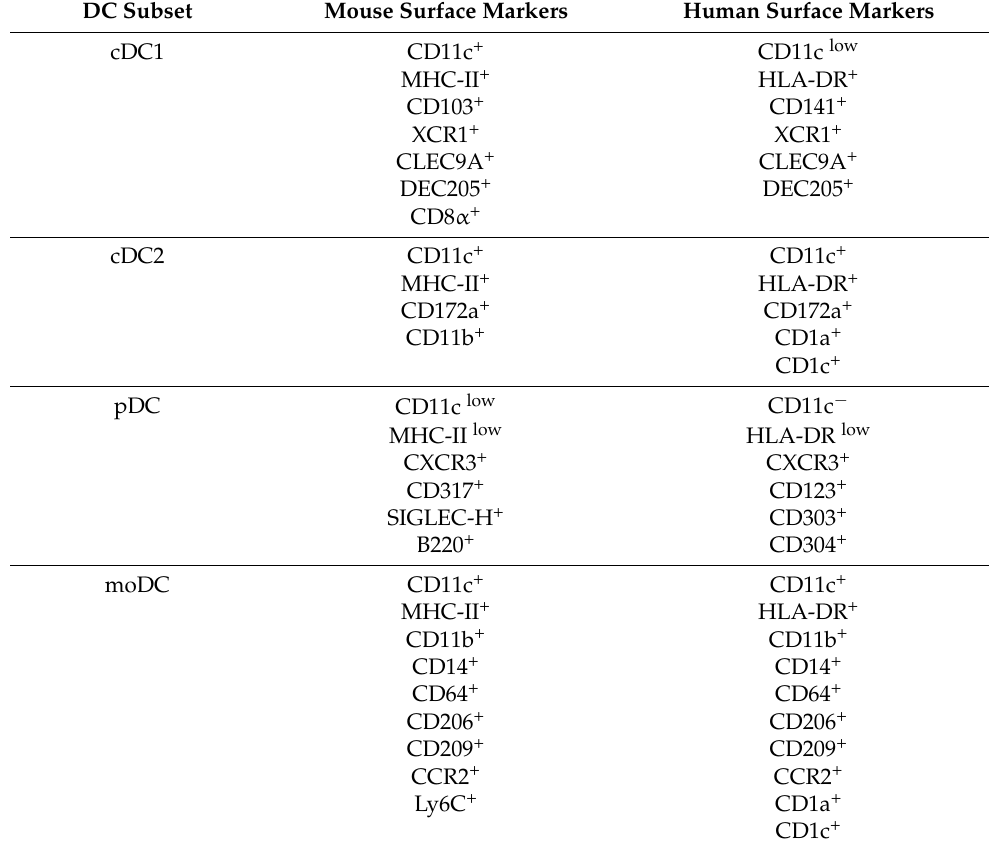
Table 1. Mouse and human DC